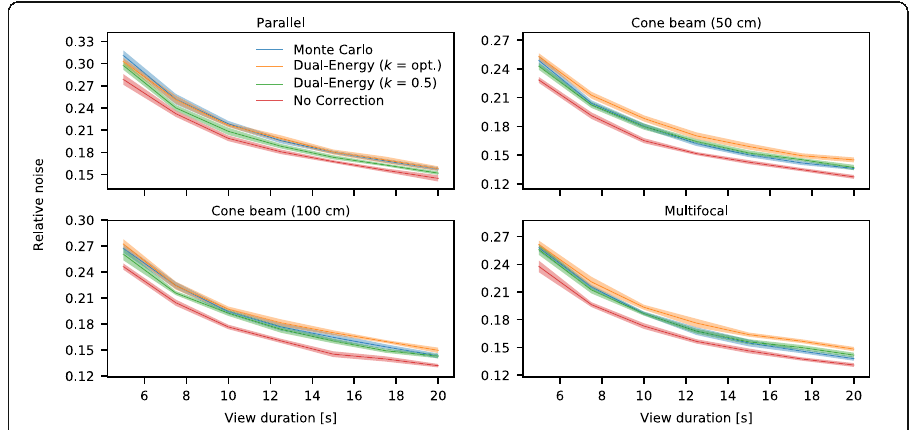
Fig. 13 Noise levels, normalized to the mean activity, for the scatter correction methods and for the reconstruction without scatter correction, for the four considered